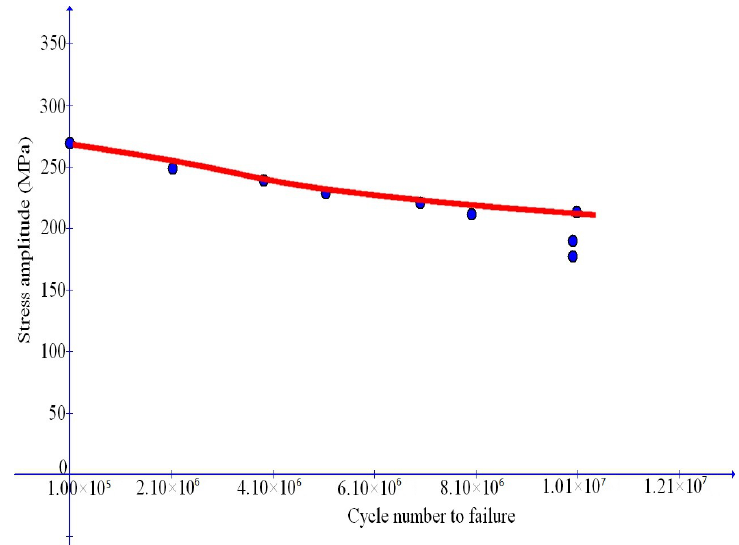
Figure 9. Comparison of simulation results with fatigue failure data (dots) from Sivananth et al. [7] for Al-matrix composite with 12% (wt) TiC reinforcing